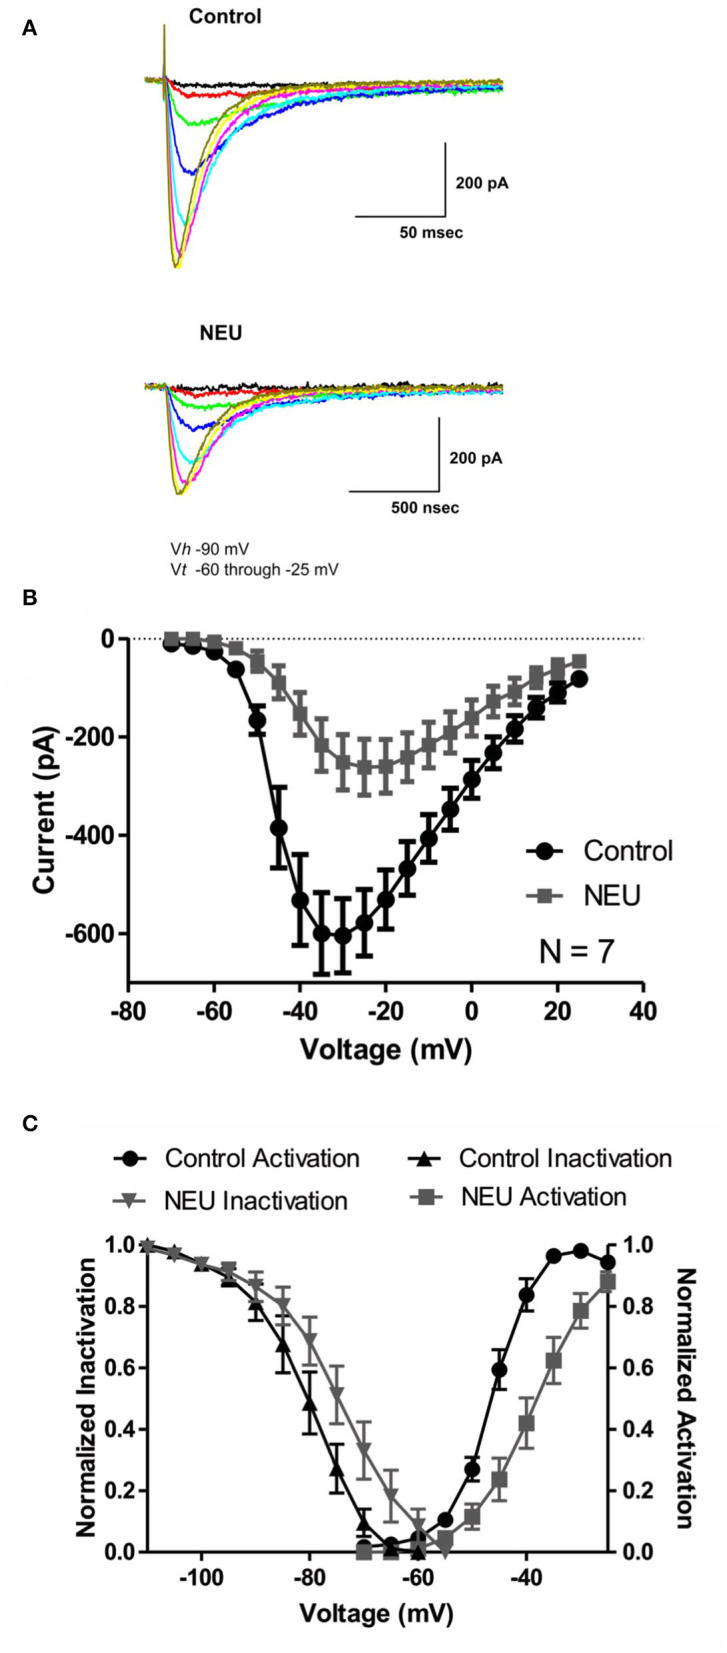
Effects of treatments with NEU (1.5 U/ml for 1–3 h) on current-voltage (I-V) relationships in HEK293 cells expressing stable CaV3.2 channels grown in hyperglycemic cell culture medium. (A) Traces represent families of CaV3.2 T-currents evoked in representative HEK293 cells in control (top panel) vs. treated (bottom panel) cohort by voltage steps from holding potential (Vh) of −90 mV to test potentials (Vt) from −60 to −25 mV in increments of 5 mV. Traces from two cells that were evoked at the same depolarizing test potentials are depicted in the same color. (B) Graph of I-V curves shows averages of peak currents at wide range of potentials from 7 cells in control untreated conditions (black symbols) and population of cell after treatment with NEU (gray symbols). Note that NEU treatment decreased peak currents over the range of test potentials more than 2-fold. (C) When compared to untreated control cells (black symbols) treatment of HEK293 cells with NEU (gray symbols) induced significant shift of V50 in steady-state inactivation curves from −79.7 ± 2.3 mV (n = 6) to −72.0 ± 2.4 mV (n = 9, p < 0.05). Similarly NEU induced depolarizing shift of V50 for steady-state activation from −45.7 ± 1.0 mV in control conditions to −37.9 ± 1.9 mV after NEU treatment (n = 7, p < 0.01). We used 2 mM Ca2+ as a charge carrier in these experiments.